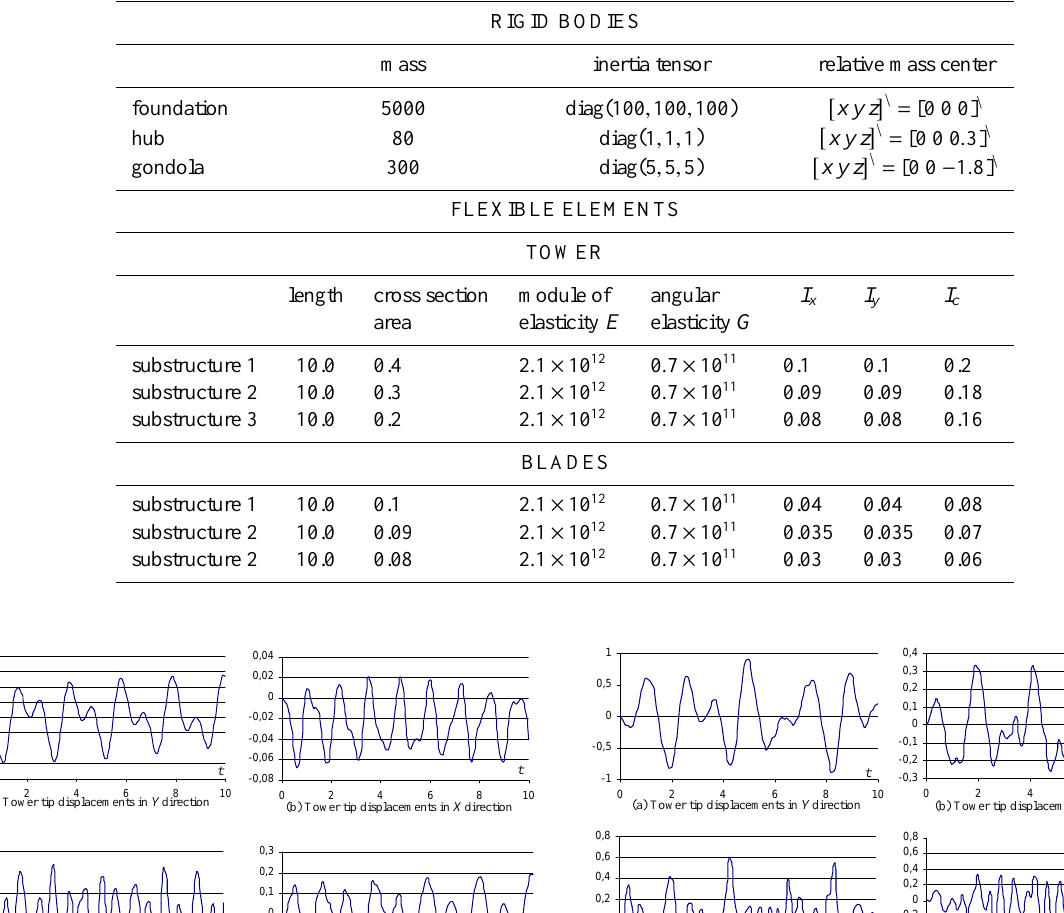
Table 1. Design and mass parameters of the WPG virtual structure (all measures are in SI).